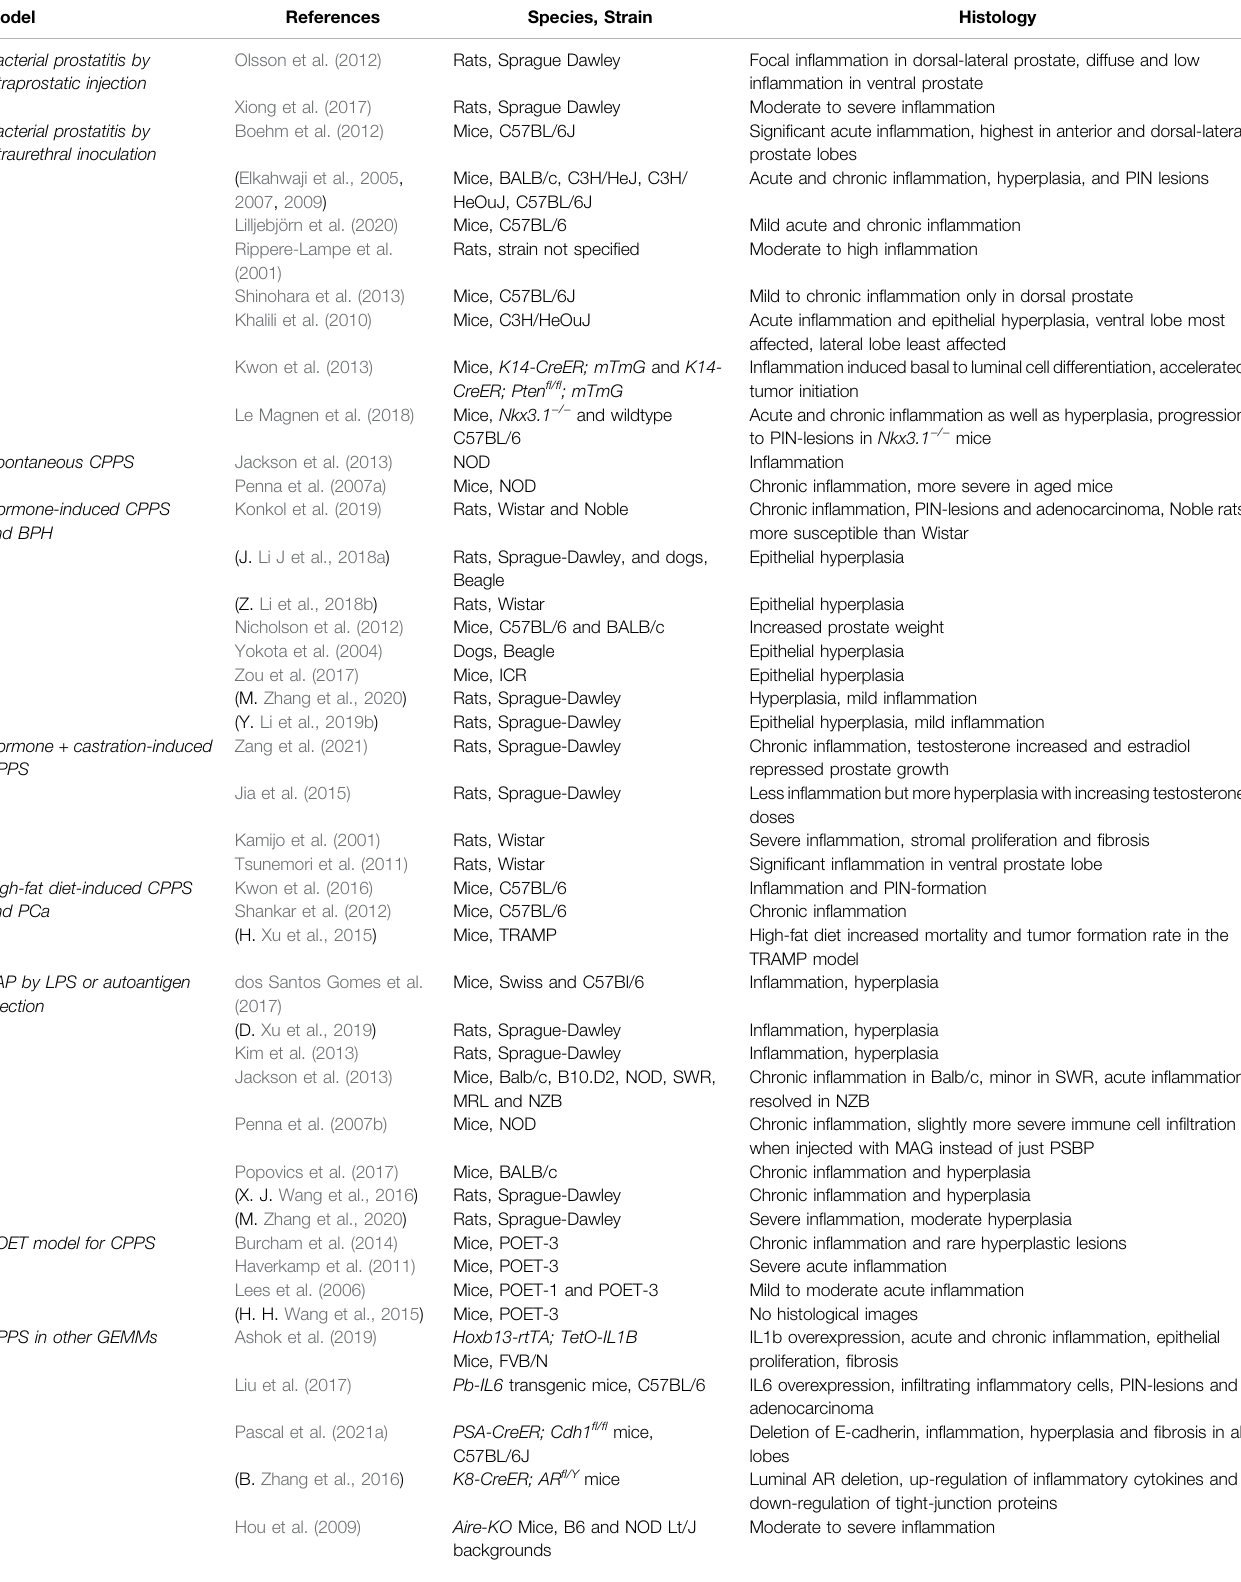
TABLE 1 | Animal models of prostatitis and in fl ammation-associated BPH and PCa.